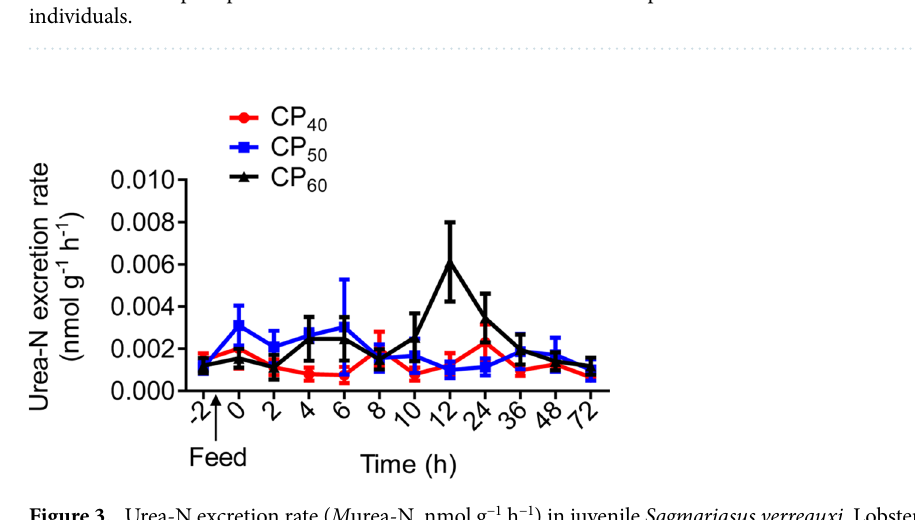
Figure 3. Urea-N excretion rate ( M urea-N, nmol g −1 h −1 ) in juvenile Sagmariasus verreauxi . Lobsters were reared at 21 °C and fed 15 N-labeled feeds at 1.5% body weight at three crude protein levels: 40%, 50% and 60%, corresponding to CP 40 , CP 50 and CP 60 treatments, respectively. The M urea-N at − 2 h indicates the routine M urea-N. The first post-prandial M urea-N was recorded at 0 h. All data represent mean ± standard error (SE) of 6